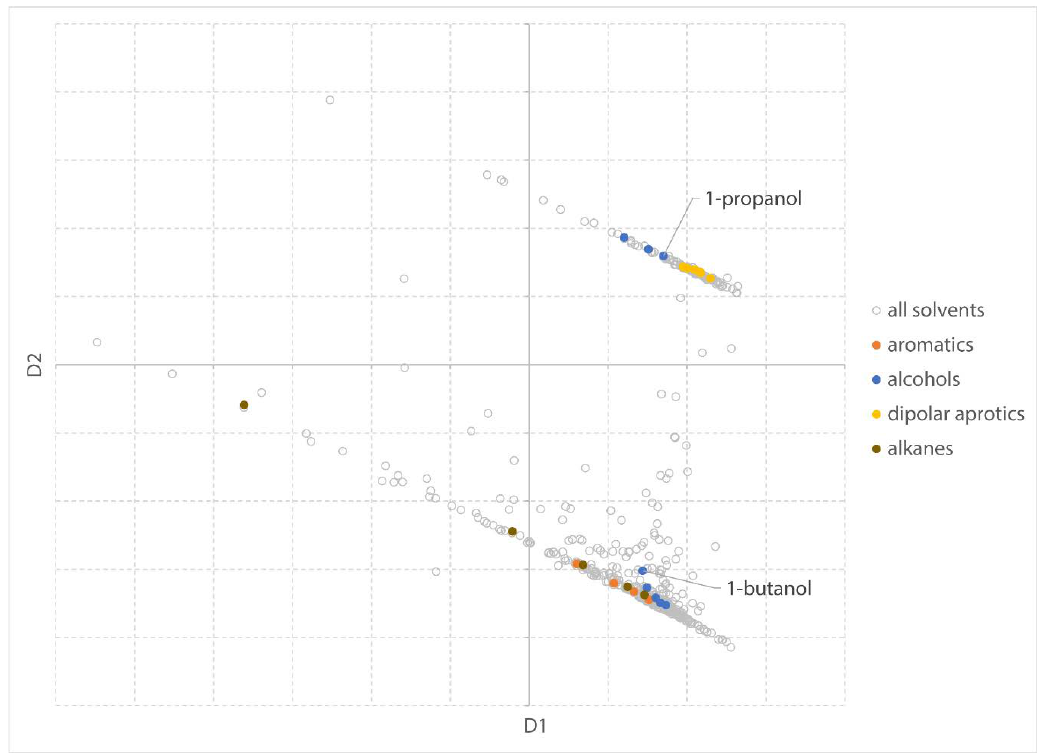
Figure 4. MDS plot of all solvents present in the dataset. Dimension 1 (D1) on x-axis and dimension 2 (D2) on y-axis. Small subsets of aromatic solvents, alcohols, dipolar aprotic solvents, and alkanes are highlighted.